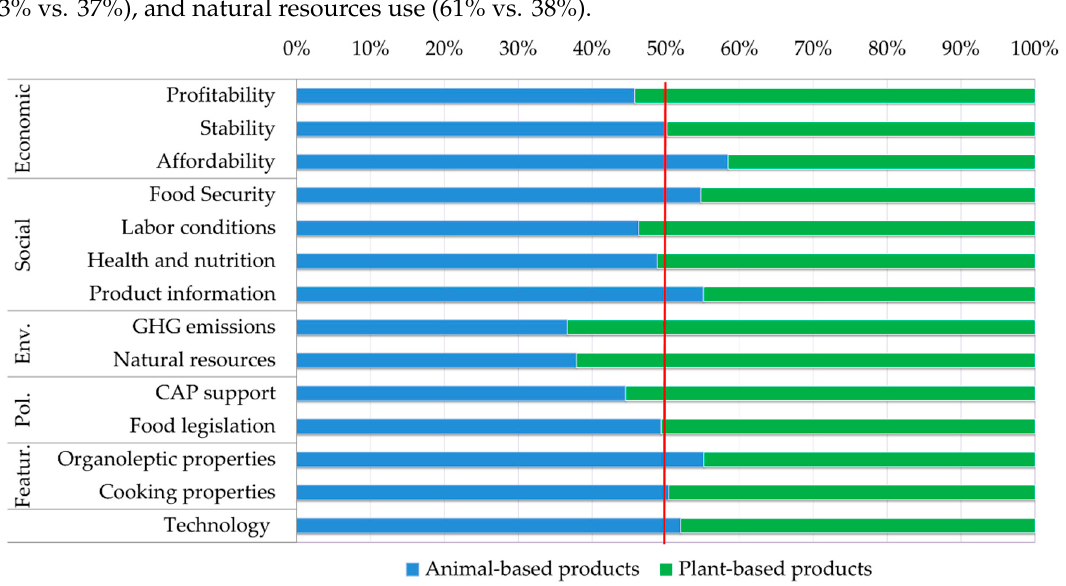
Figure 7. Overall performance of food products grouped into animal-based and plant-based products, under each sub-criterion (all stakeholder’ views). Average weight of each sub-criterion (%).